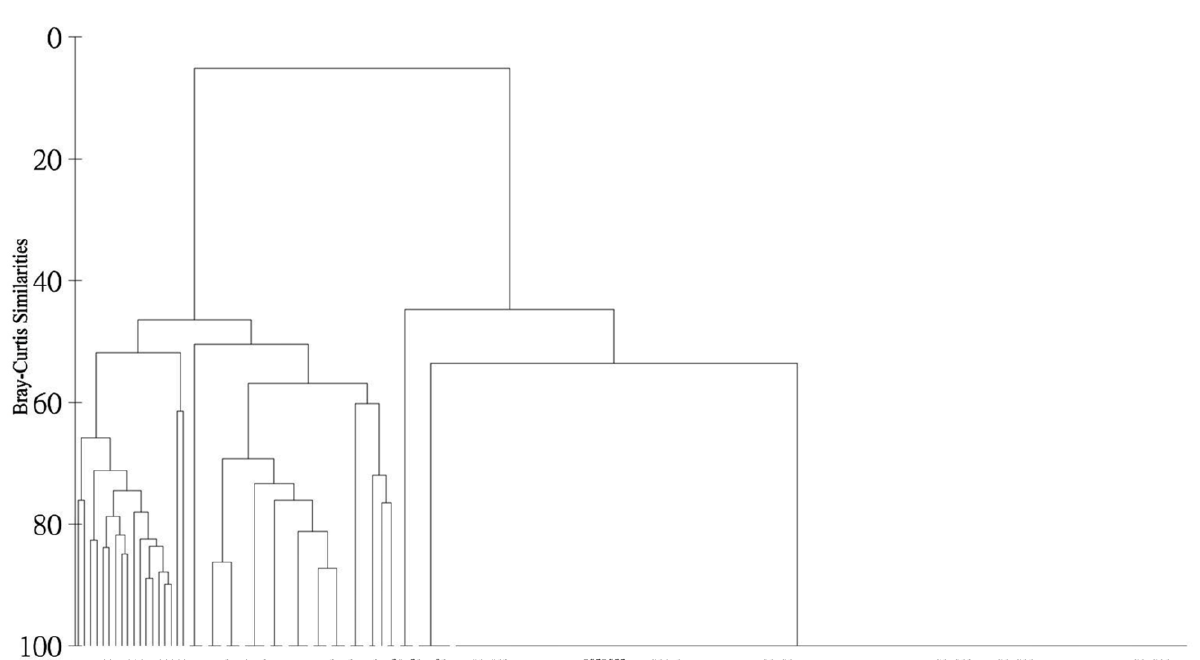
Figure 4. Non-metric MDS ordination of abundance data for crab communities sampled monthly in the study area.